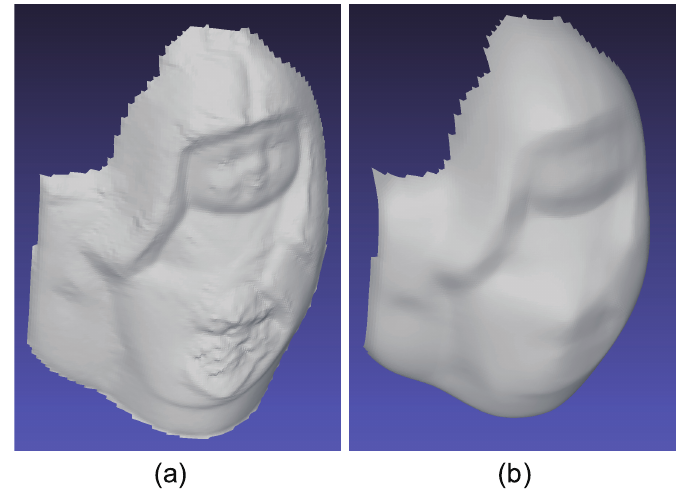
Figure 21. The results for doll object, which causes strong specular reflection. Estimated geometry [doll]: ( a ) Naive color photometric stereo and ( b ) our method. The proposed method is not affected by the albedo difference appears at the flower basket.